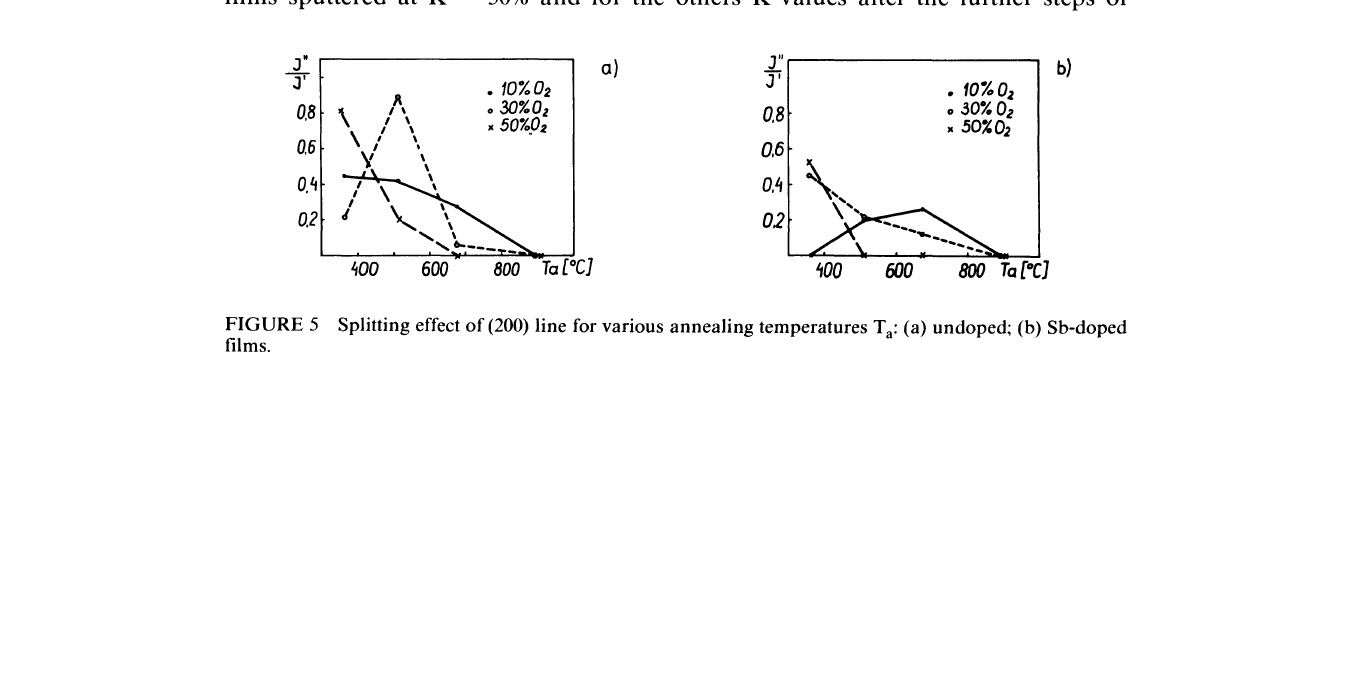
FIGURE 5 Splitting effect of (200) line for various annealing temperatures Ta: (a) undoped; (b) Sb-doped